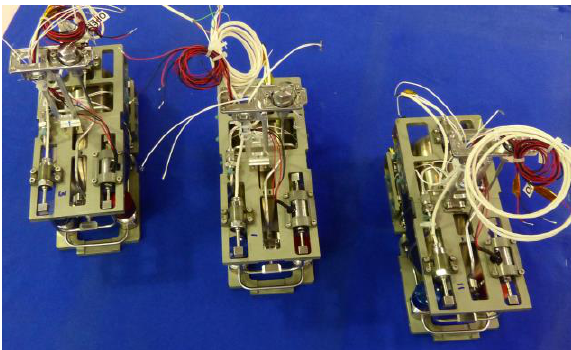
Figure 18. Photograph of the three integrated Adelis-SAMSON propulsion systems.